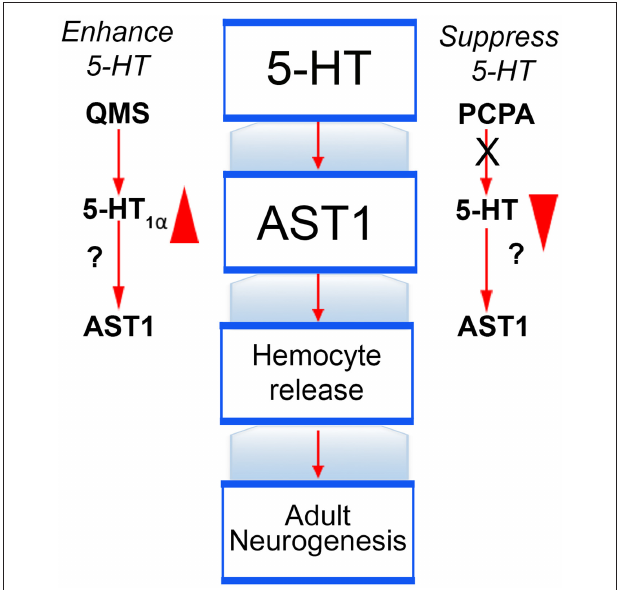
FIGURE 10 | Testing serotonin as a link between the nervous and immune systems . Our working model describing serotonin’s role in adult neurogenesis includes stimulating the expression of AST1, which in turn promotes the release of semi-granular hemocytes and accelerates the rate of adult neurogenesis. These relationships will be further tested using agents that enhance or suppress serotonin’s action (e.g., quizapine maleate salt [QMS] and PCPA, respectively). While the influence of these compounds on adult neurogenesis in crayfish is known, it has not yet been determined if these effects are mediated by AST1, or result from direct influences of